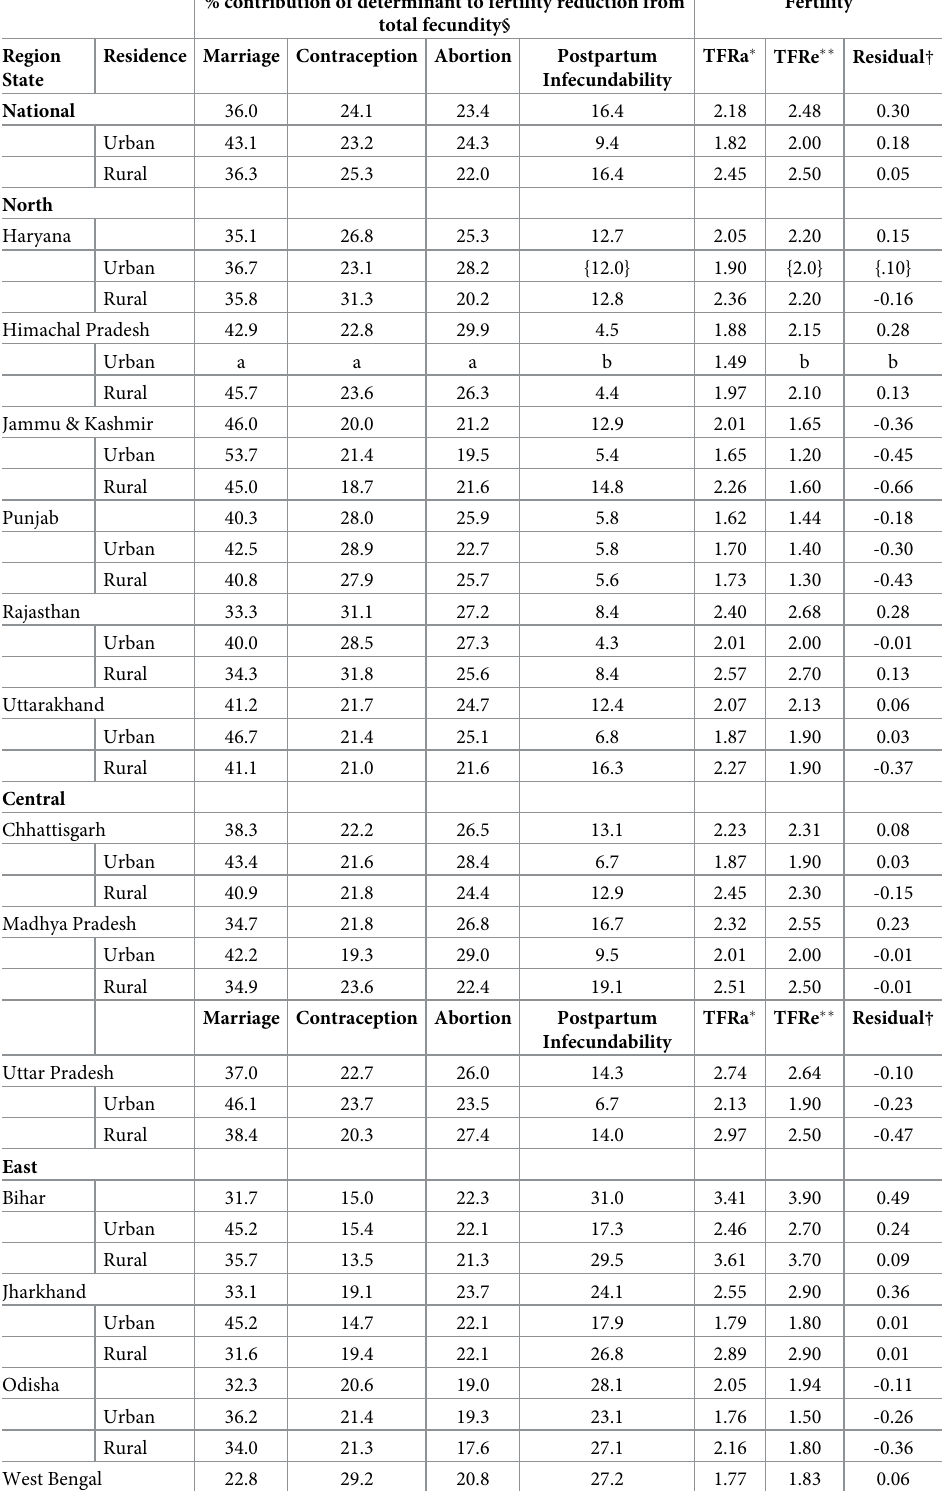
Table 3. Estimates of the percent contribution of four key proximate determinants to fertility reduction, actual TFR, estimated TFR and residual by residence: National and by state, India 2015–16. % contribution of determinant to fertility reduction from total fecundity§